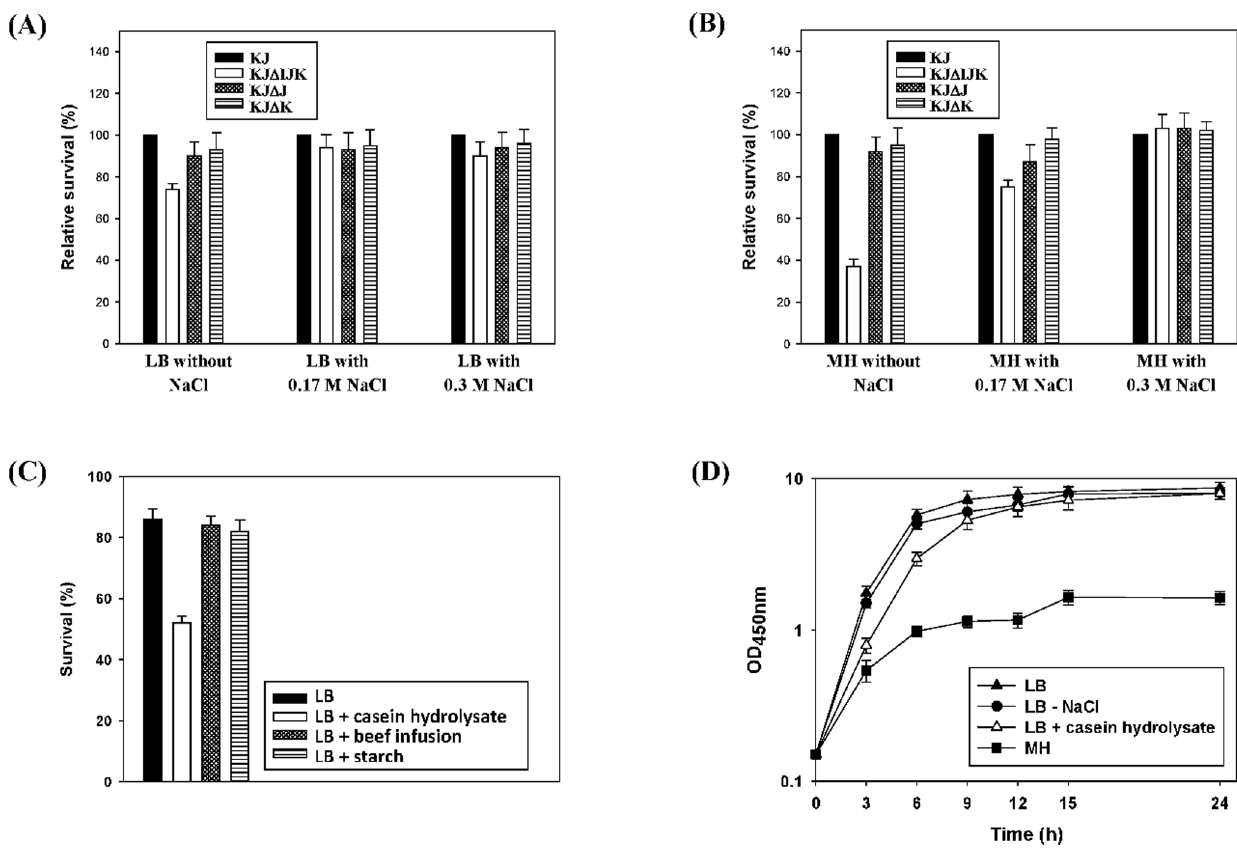
Figure 2. The role of SmeIJK pump in the tolerance to hypo-osomolarity and casein hydrolysate. The data are the average of the measurements made in triplicate. (A) The relative survival of KJ D IJK, KJ D J, and KJ D K to the wild-type KJ in the LB medium containing different concentrations of NaCl. The relative survival percentage of individual mutant to the wild-type KJ, at each cultured condition, was calculated using the OD 450 nm of the wild-type KJ as 100%. (B) The relative survival of KJ D IJK, KJ D J, and KJ D K to the wild-type KJ in the MH medium containing different concentrations of NaCl. The relative survival percentage of individual mutant to the wild-type KJ, at each cultured condition, was calculated using the OD 450 nm of the wild-type KJ as 100%. (C) The sensitivities of KJ to SDS in LB or LB containing casein hydrolysate, beef infusion, or starch were determined by the OD 450 nm measurement. The percentage of survival was defined as the OD 450 nm ratio of the SDS-additive group to the SDS-free counterpart. (D) Growth curves of KJ D IJK grown in the media of the LB, the LB without NaCl, the LB with casein hydrolysate, and the MH, respectively.